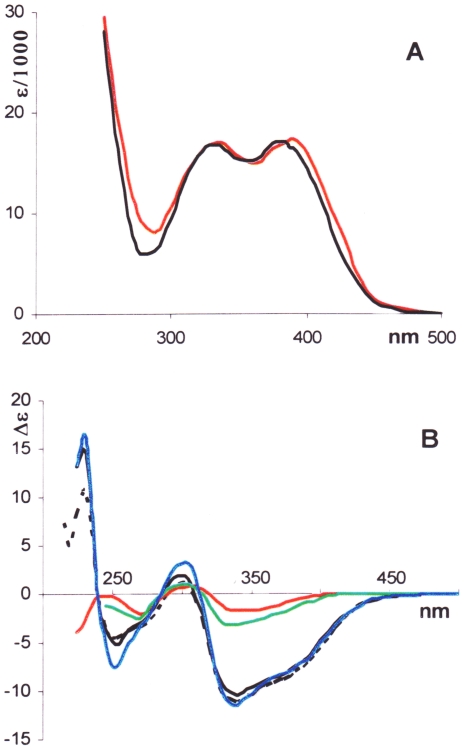
HPLC separation of conformers 5a and 5b.The Figure shows: (A) UV spectra in MeCN/H2O 40∶60 for 5a (____) and 5b (____). (B) CD spectra at ca 1°C for 5a (____) and 5b after 6–30 min (____); 95–120 min (____); overnight (____); finally CD spectrum for the equilibrium mixture 5a/5b at r.t. (-----).